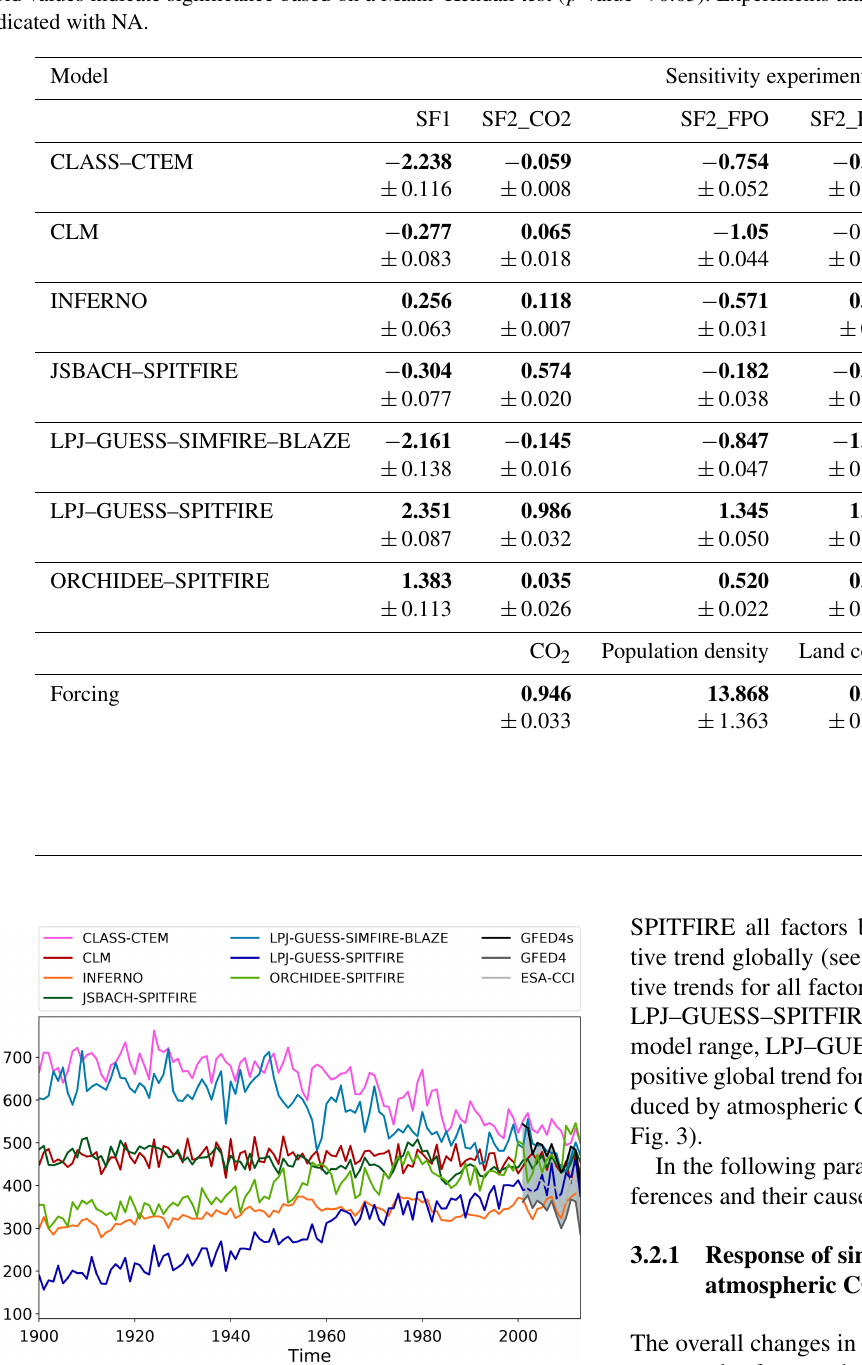
Figure 1. Annual global burned area (BA) in megahectare per year (Mhayr − 1 ) for all FireMIP models for 1921–2013 for the base- line experiment SF1. The shaded area indicates the range of annual global burned area values for the